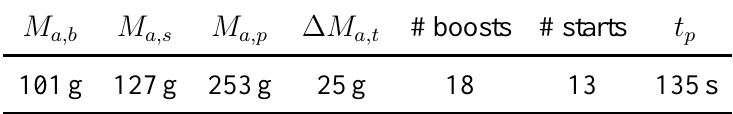
Table 3. Cumulative air masses transferred in each mode on the aNEDC for the minimum tank size.